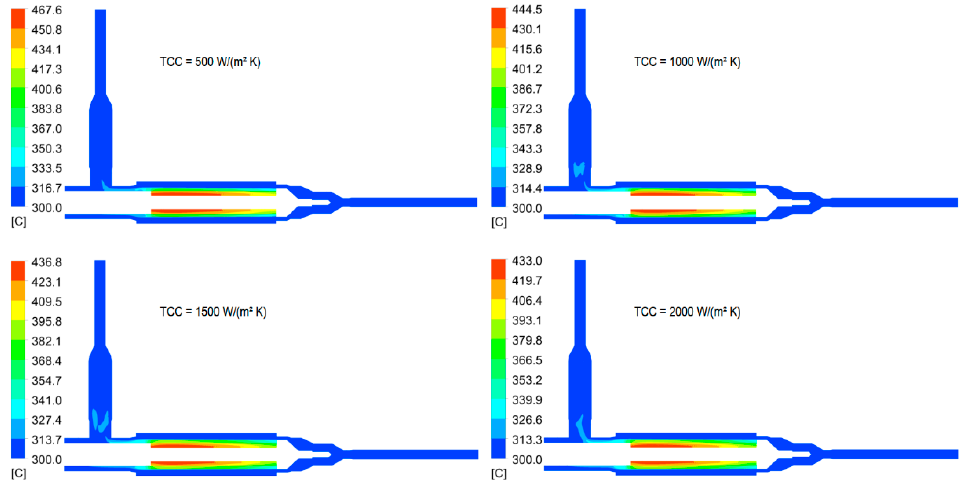
Figure 14. Temperature contours of the mockup of different TCC values.